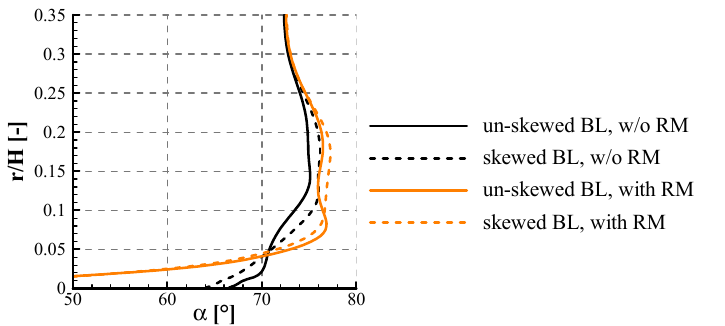
Figure 4. Effect of varying hub wall motion on pitchwise averaged flow angle in absolute frame of reference downstream of S1 (MP5), s/C = 2.0%, CFD.